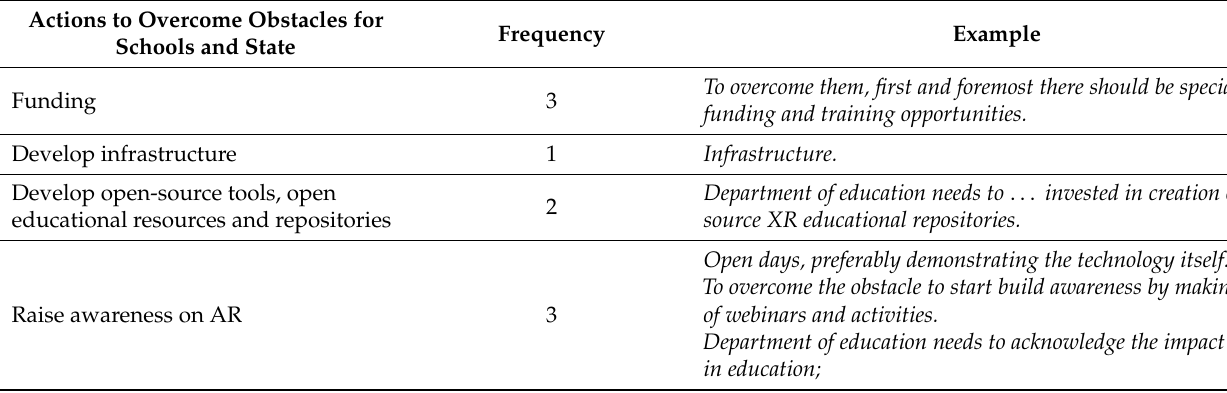
Table 18. Recommendations for schools and state.